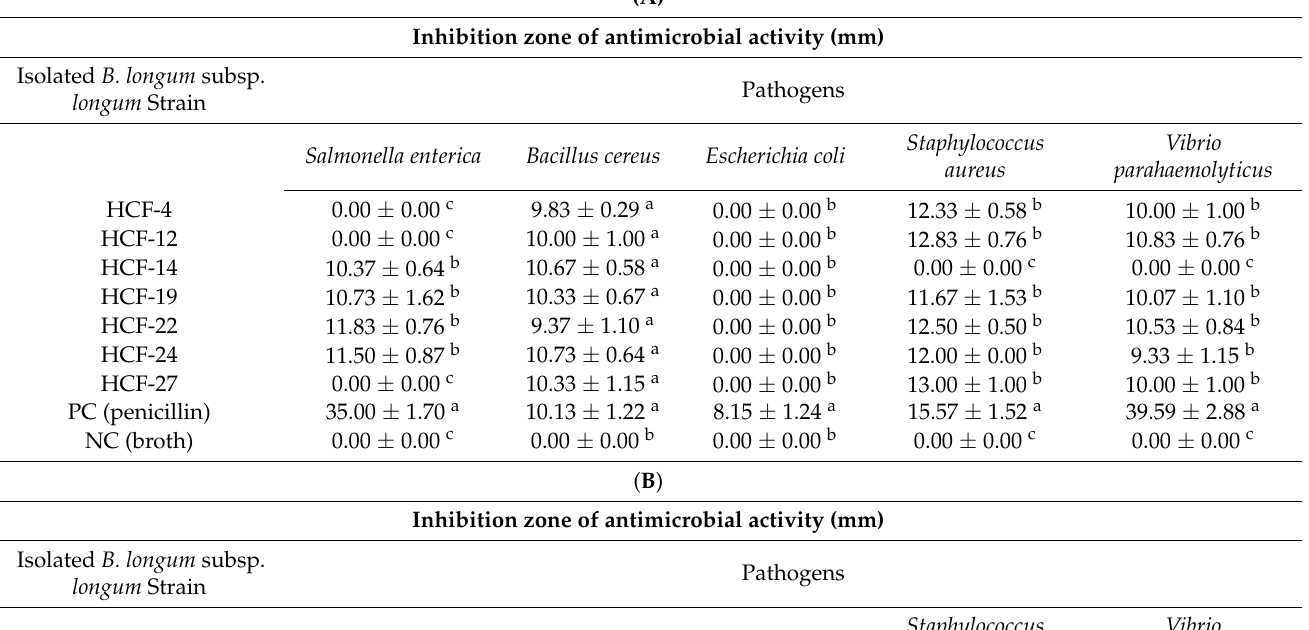
Table 2. The antimicrobial inhibition zone of (A) each isolated microorganism strain and (B) the antimicrobial activities against different pathogens.